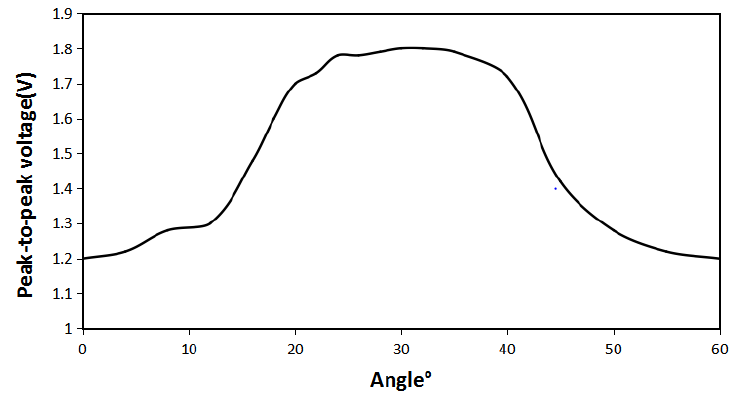
Figure 5. Peak-to-peak voltage of iron sheet and Halbach array rotor at different angles.